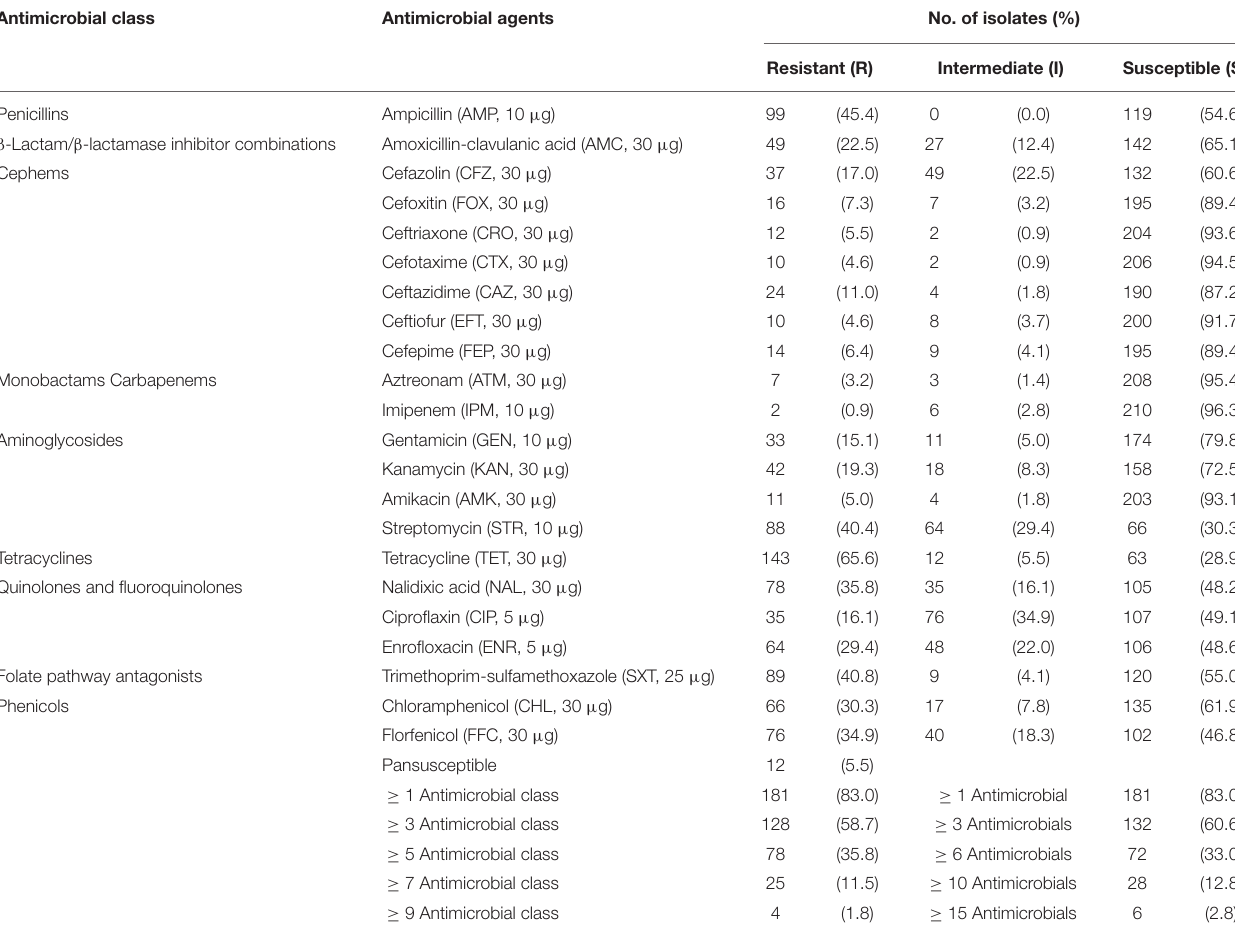
TABLE 3 | Results of antimicrobial susceptibility testing of Salmonella isolates obtained in the present study. Antimicrobial